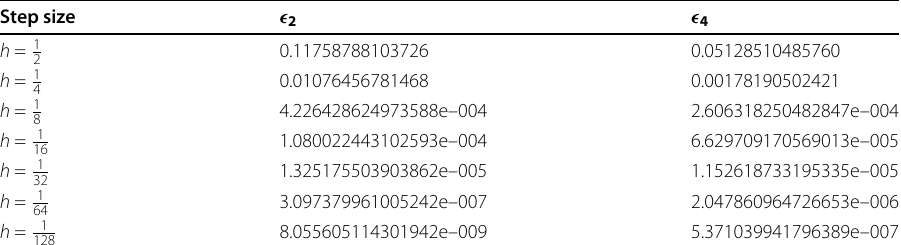
Table 1 The global error of numerical solutions for the exponential Euler method Step